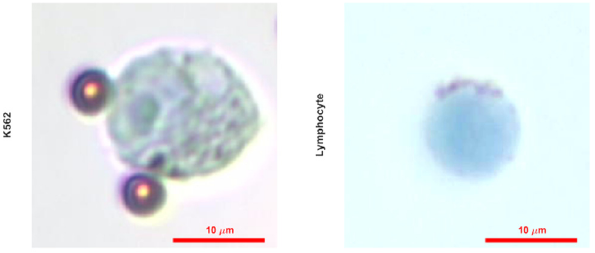
Figure 10. Microscopic images of single K562 and lymphocyte cells stained with 0.1% TB taken with 50× objective.